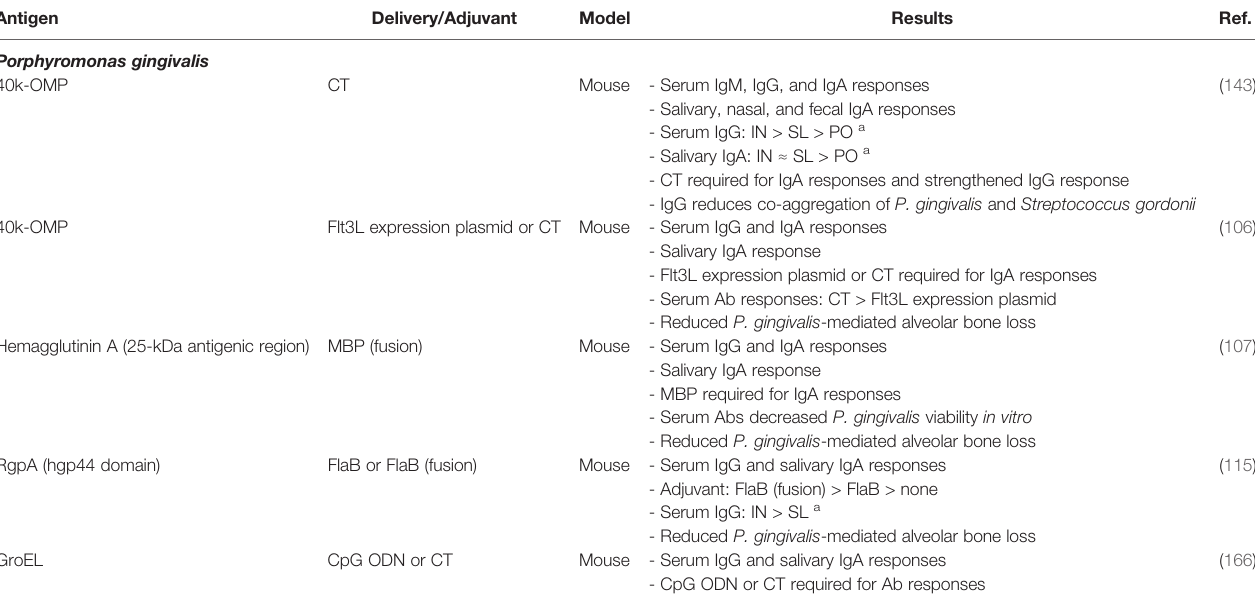
Antigen Delivery/Adjuvant Model